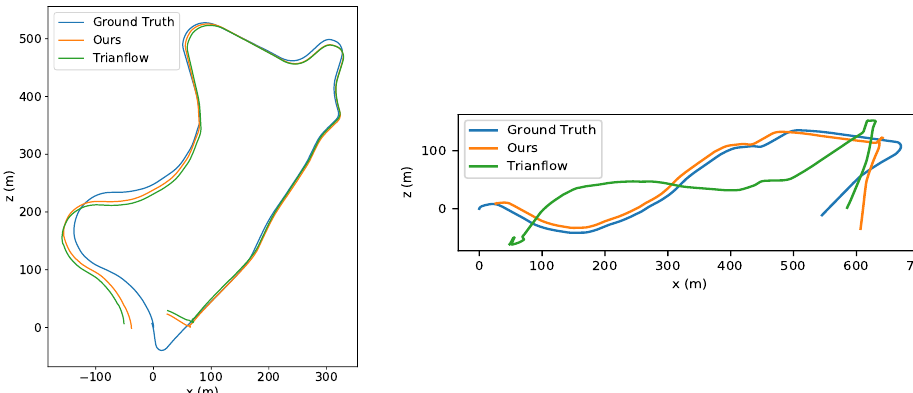
Figure 1. The estimated trajectories of sequences 09 and 10 from the KITTI Odometry dataset. We took the stride as four, that is, only one in every four frames was used for trajectory computing, to simulate fast moving. As shown, our model still worked well in fast-moving